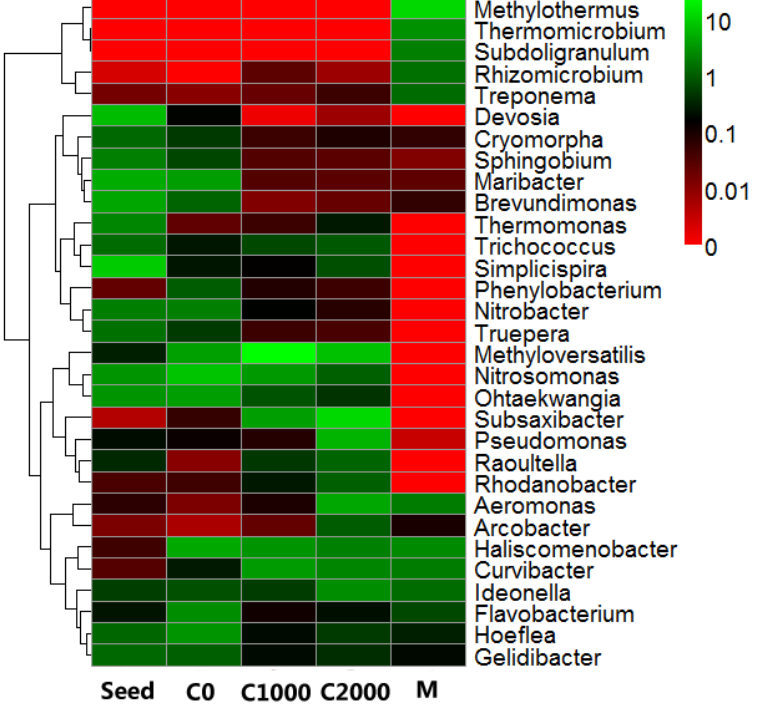
Figure 6. Heatmap of the relative abundance of bacterial genera in all samples.